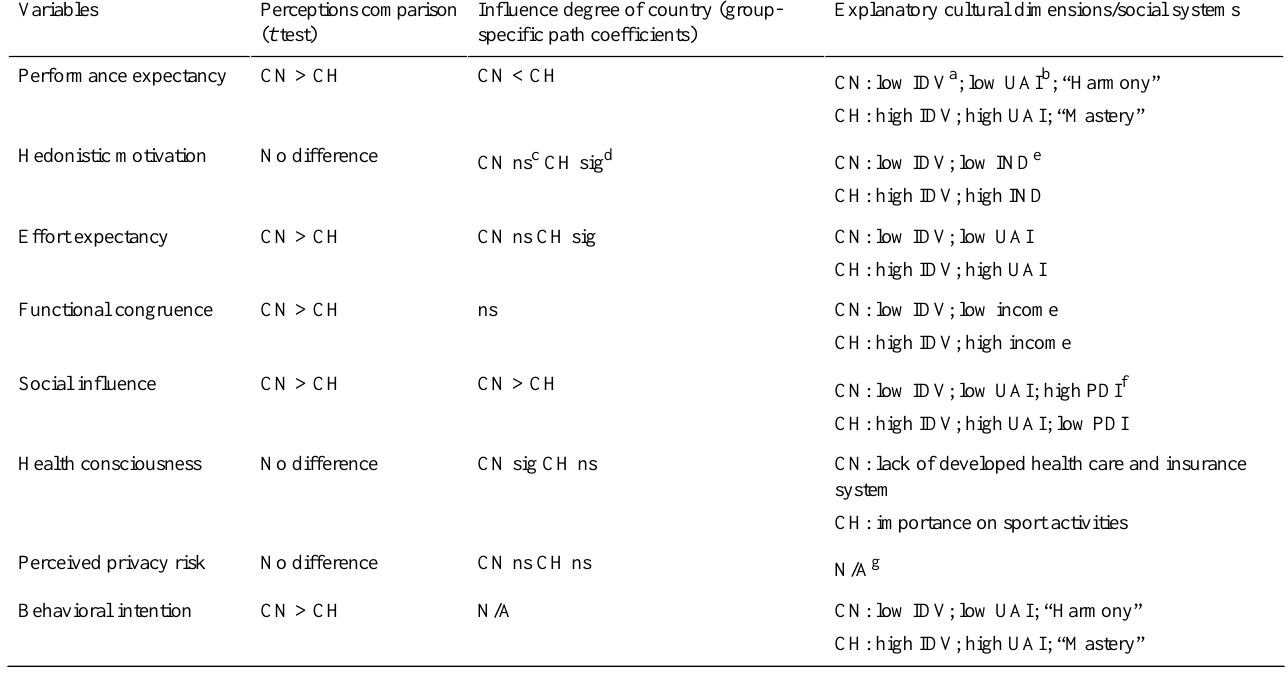
Table 8. Influential cultural values on differences between China (CN) and Switzerland